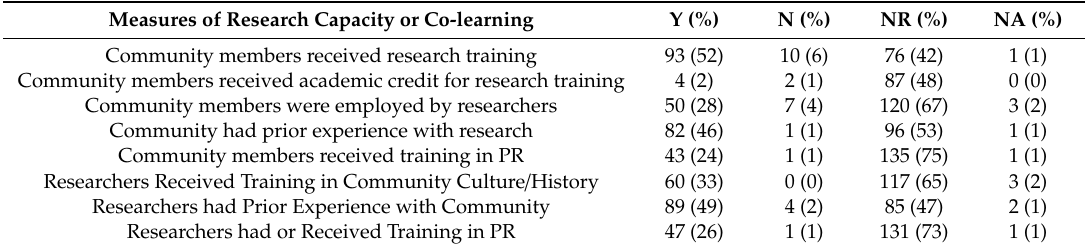
Table 5. Community Research Capacity and